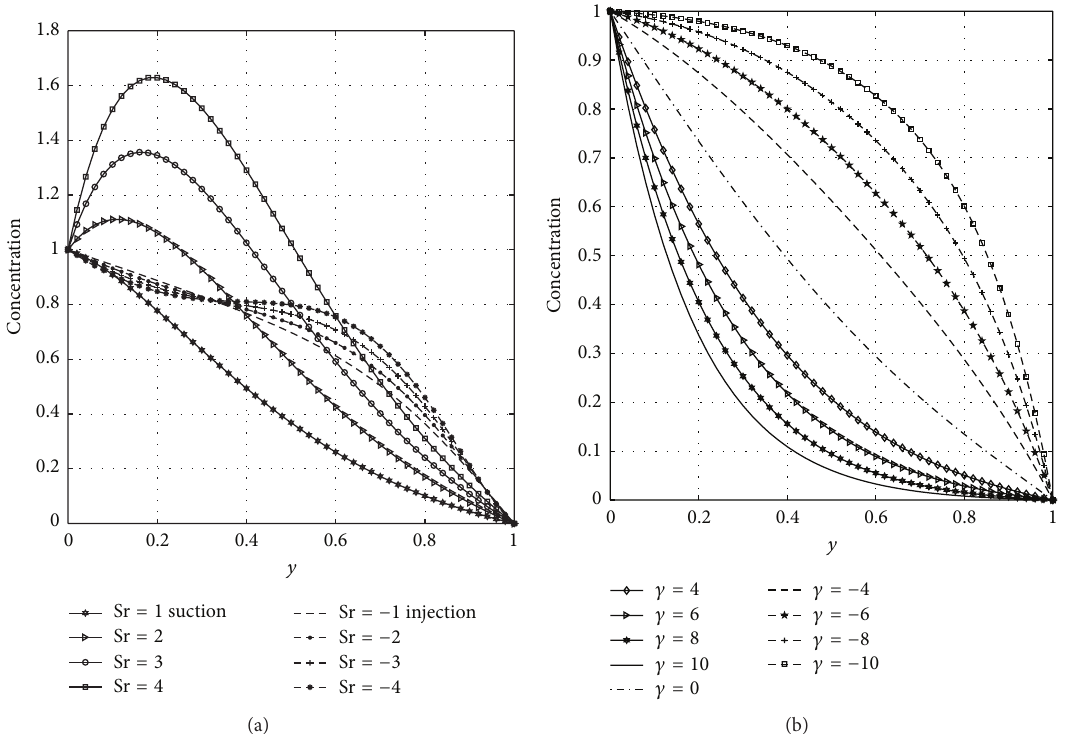
Figure 6: Effects of Soret number (Sr) and suction/injection ( 𝛾 ) on